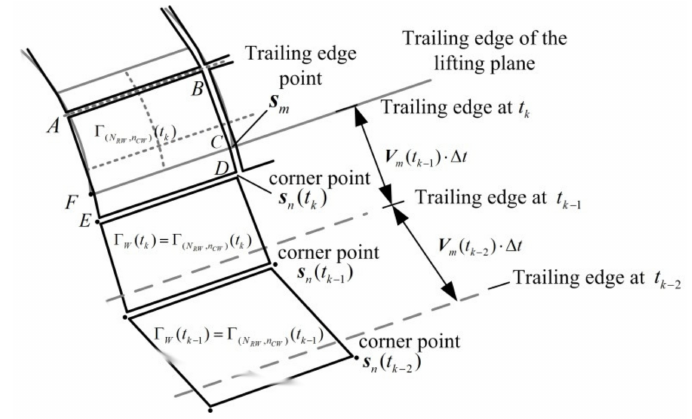
Figure 3. Nonplanar unsteady vortex ring